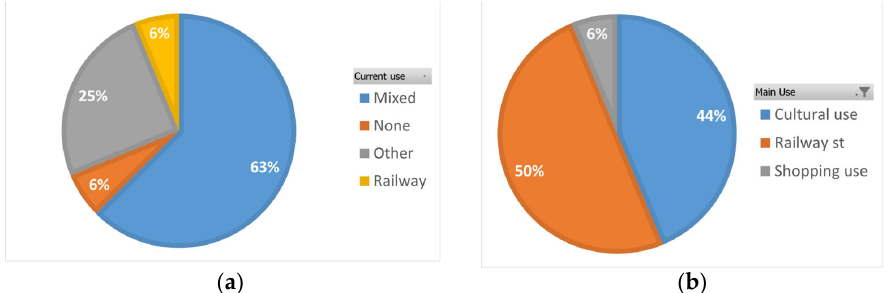
Figure 3. ( a ) Current use of the station analyzed. Own elaboration. ( b ) Main use of the station analyzed. Own elaboration.